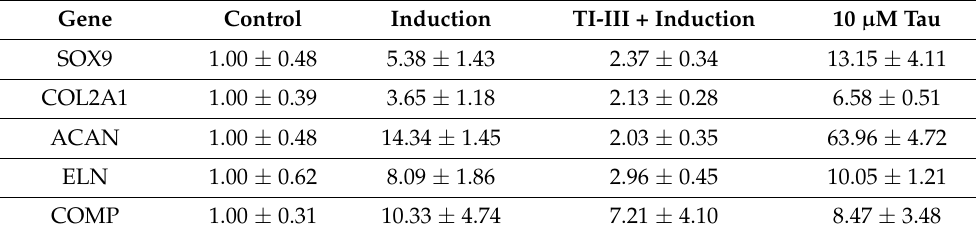
Table 8. Relative gene expression of chondrogenesis related genes (fold change).